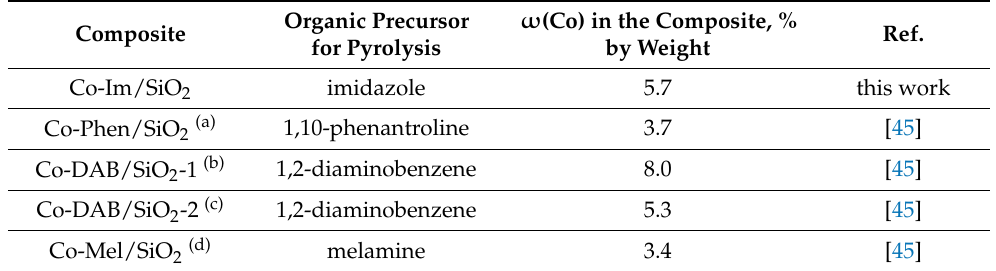
Table 1. Abbreviations used for the definition of the composites together with Co content in these